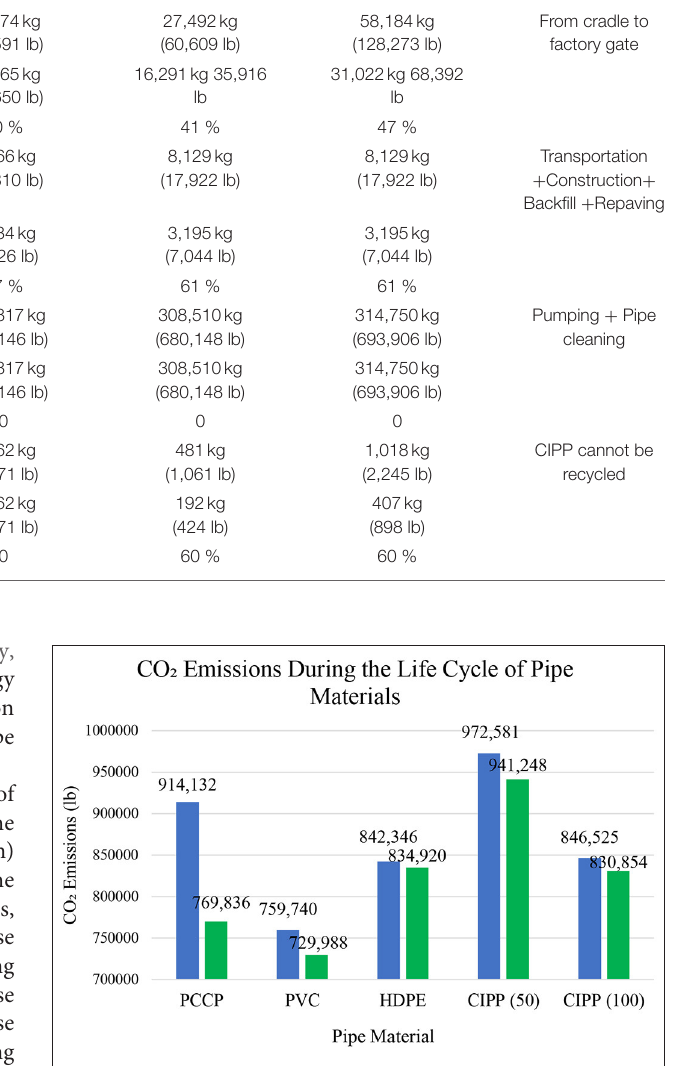
FIGURE 7 | The difference between the carbon emissions during the life cycle of pipeline materials before and after optimization, CIPP: the first two columns are presenting a 50-years life expectancy, while the last two columns are presenting a 100-years life